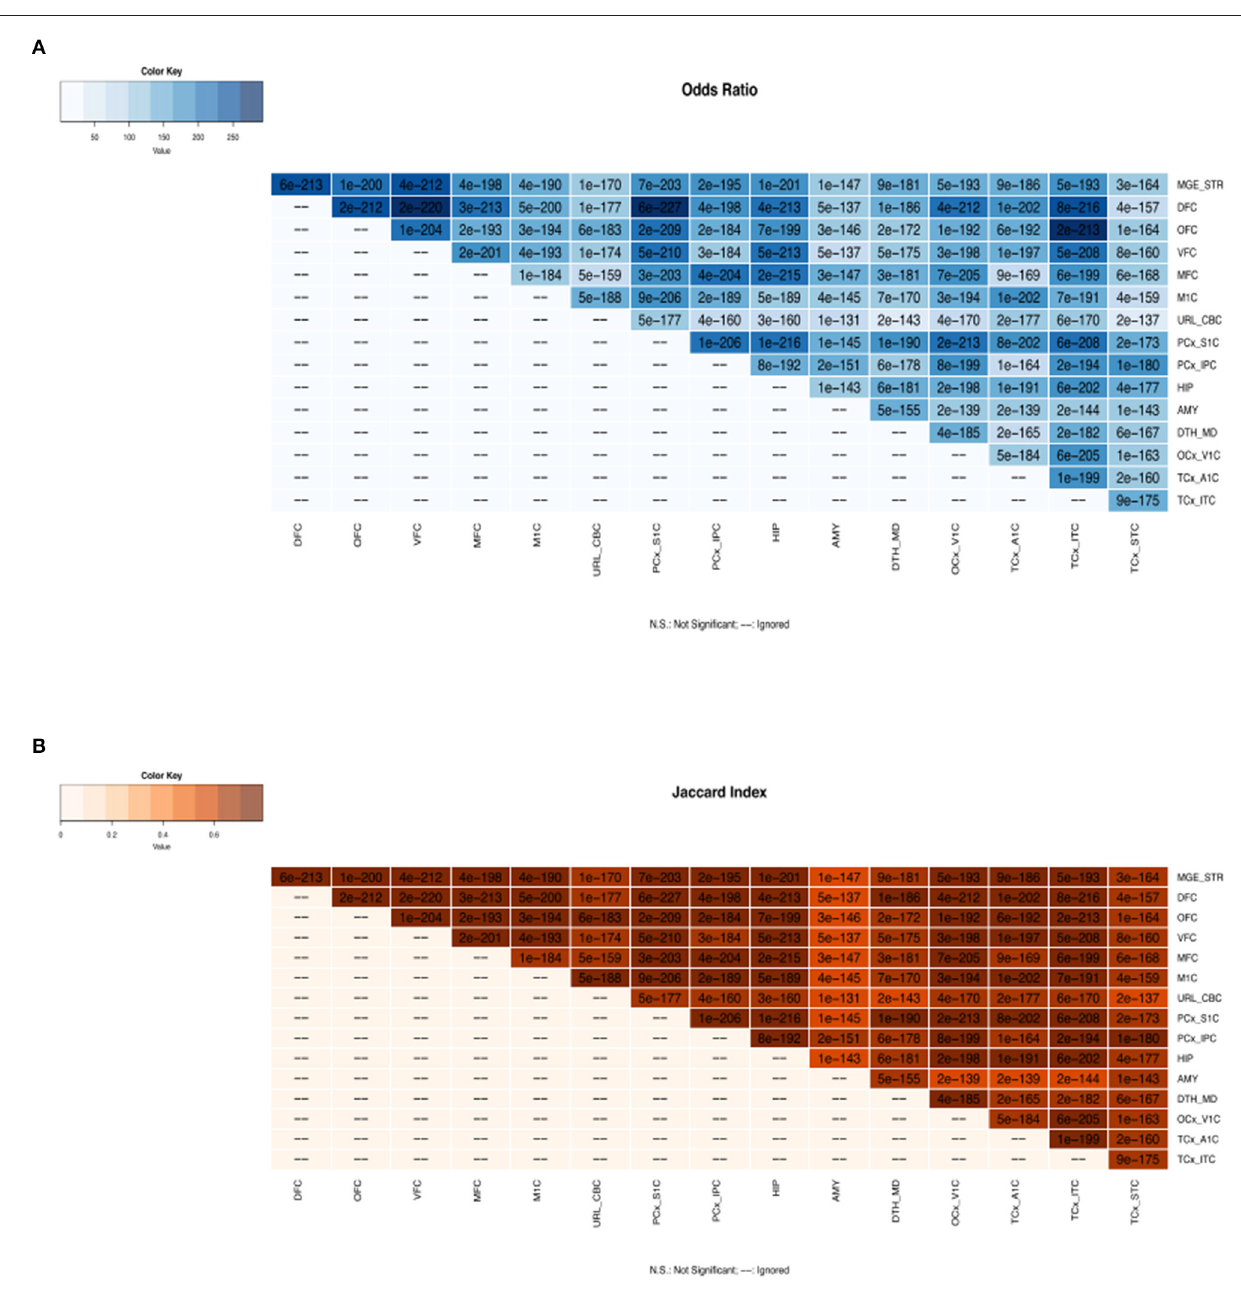
FIGURE 1 | Regulatory gene overlap analysis across all brain regions. (A) The color key represents the odds ratios and the significant p -values are superimposed on the grids. The odds ratio and p -values indicate that there is strong association of gene regulators across brain regions. (B) The color key represents the Jaccard index and the significant p -values are superimposed on the grids. The Jaccard index measures the similarity of gene regulators across brain regions. MGE_STR, Medial ganglionic eminence_Striatum; DFC, dorsolateral prefrontal cortex; OFC, orbital frontal cortex; VFC, ventrolateral prefrontal cortex; MFC, medial prefrontal